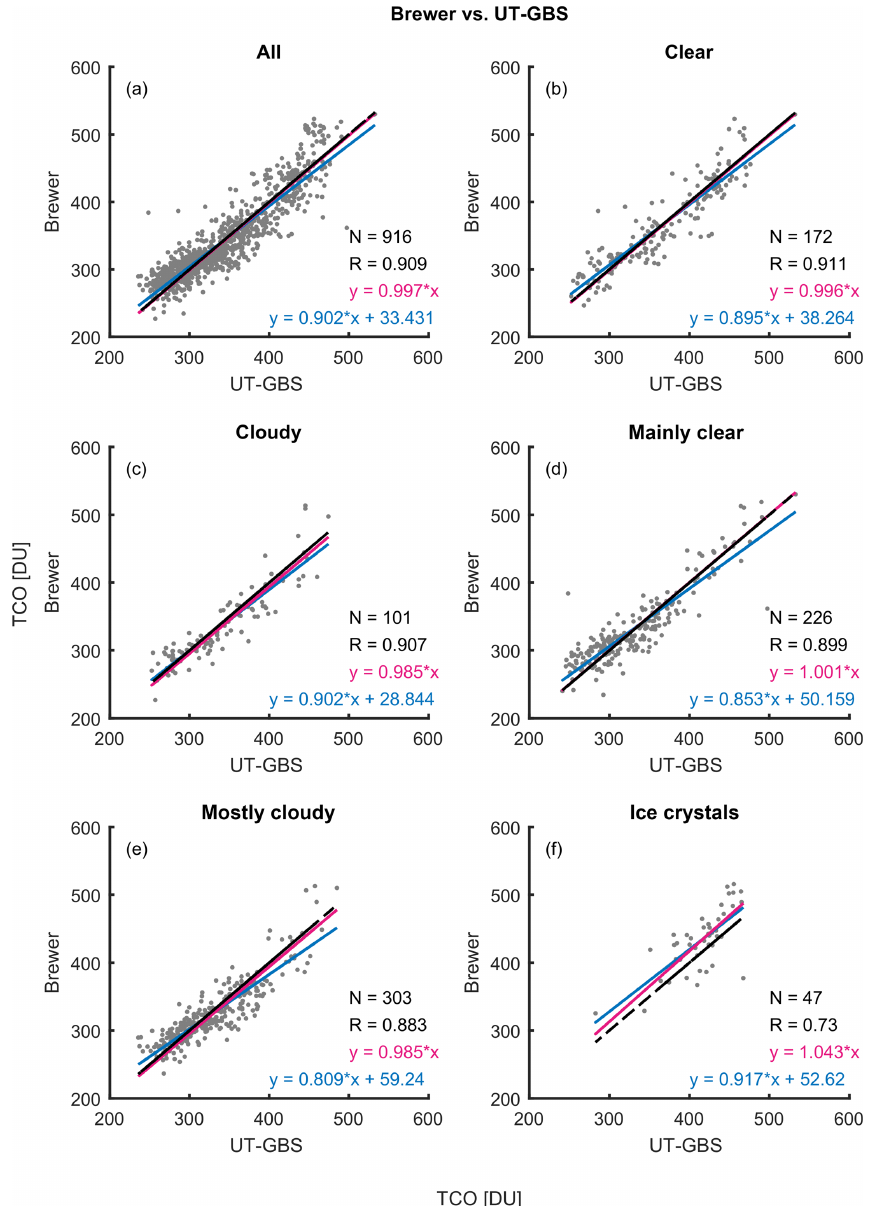
Figure 6. Scatter plots of Brewer total column ozone vs. UT-GBS TCO. Panel (a) shows the scatter plot of all coincident measurements of Brewer and UT-GBS. Panels (b) to (f) show scatter plots with weather conditions indicated in their titles. On each scatter plot, the red line is the linear fit with intercept set to 0, the blue line is a simple linear fit, and the black line is the one-to-one line.